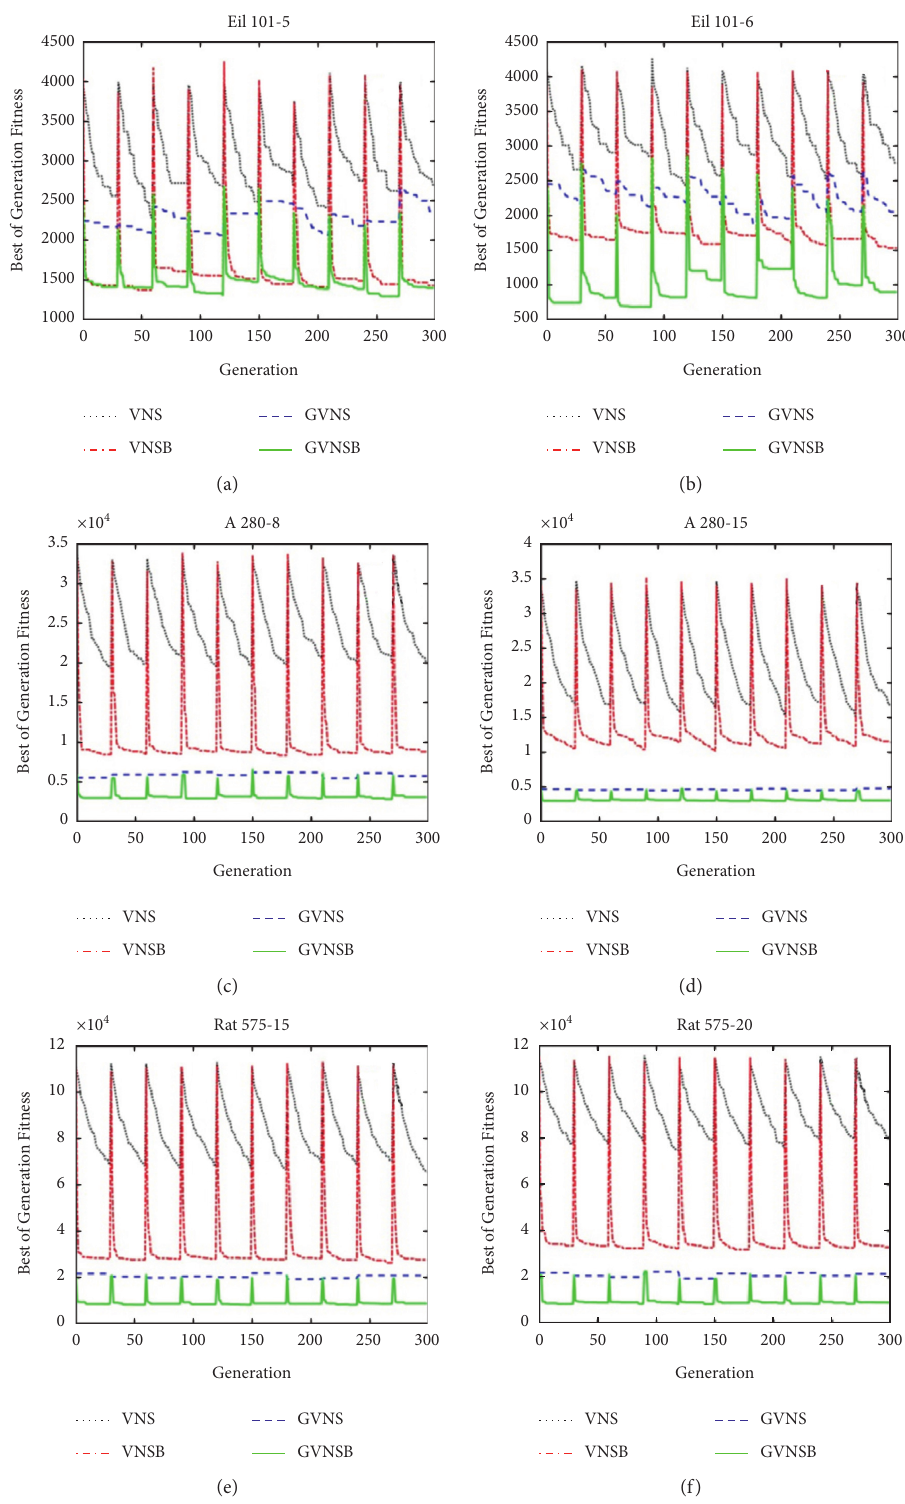
Figure 8: Dynamic performance of algorithms at different test cases at environment τ � 30. (a) Eil 101–5, ρ � 0 . 1. (b) Eil 101–6, ρ � 0 . 5. (c) A280-8, ρ � 0 . 5. (d) A280-15, ρ � 1 . 0. (e) Rat 575–15, ρ � 0 . 5. (f) Rat 575–20, ρ � 0 .